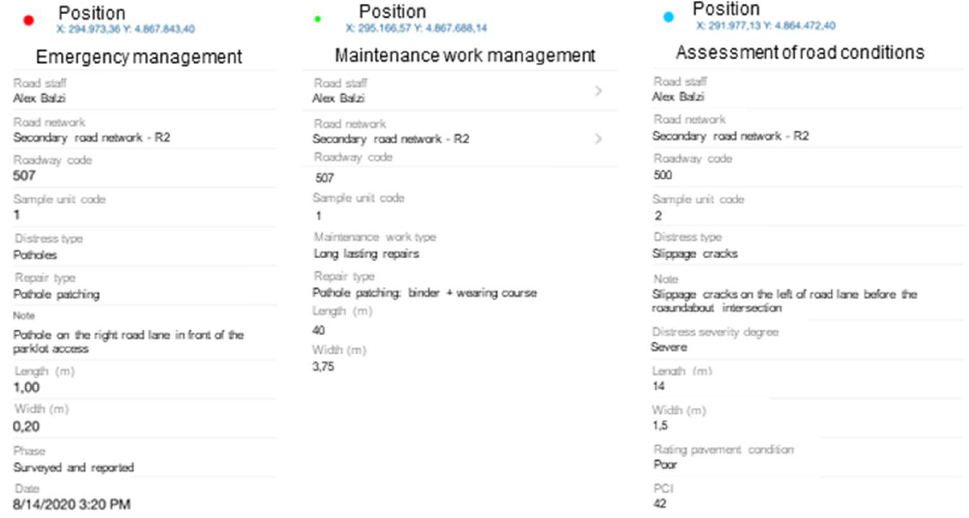
Figure 7. Example of GIS-based services on mobile devices for road pavement monitoring